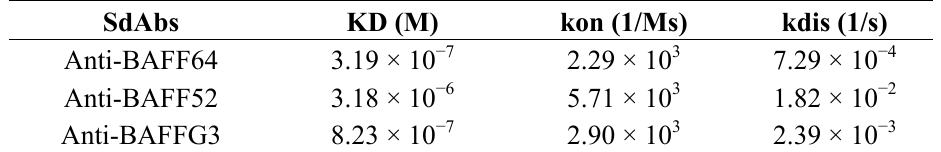
All constants were calculated from five data sets obtained with different concentrations of VHHs (from 1.25 to 20 µM) by a global Langmuir 1.1